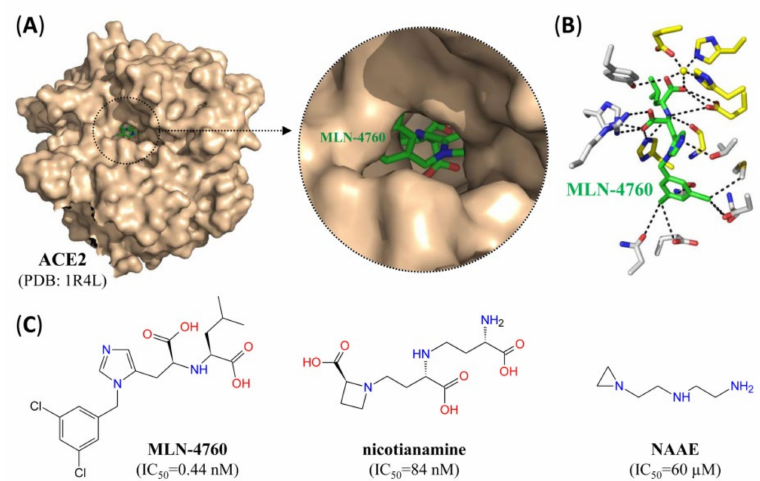
Figure 3. Mechanism of action and structure of small molecule ACE2 inhibitors. ( A ) Surface representation of the crystal structure of ACE2 with the small molecule inhibitor MLN-4760 (green) bound to the active site. Inset: close-up view showing part of the inhibitor bound to the active site. ( B ) Stick representation of MLN-4760 (green) bound to residues at the active site. Catalytic residues and the active site zinc ion are indicated in yellow. Dashed black lines indicate formation of hydrogen bonds. ( C ) Structure of di ff erent small molecule inhibitors of ACE2 and IC 50 values for suppression of human ACE2.